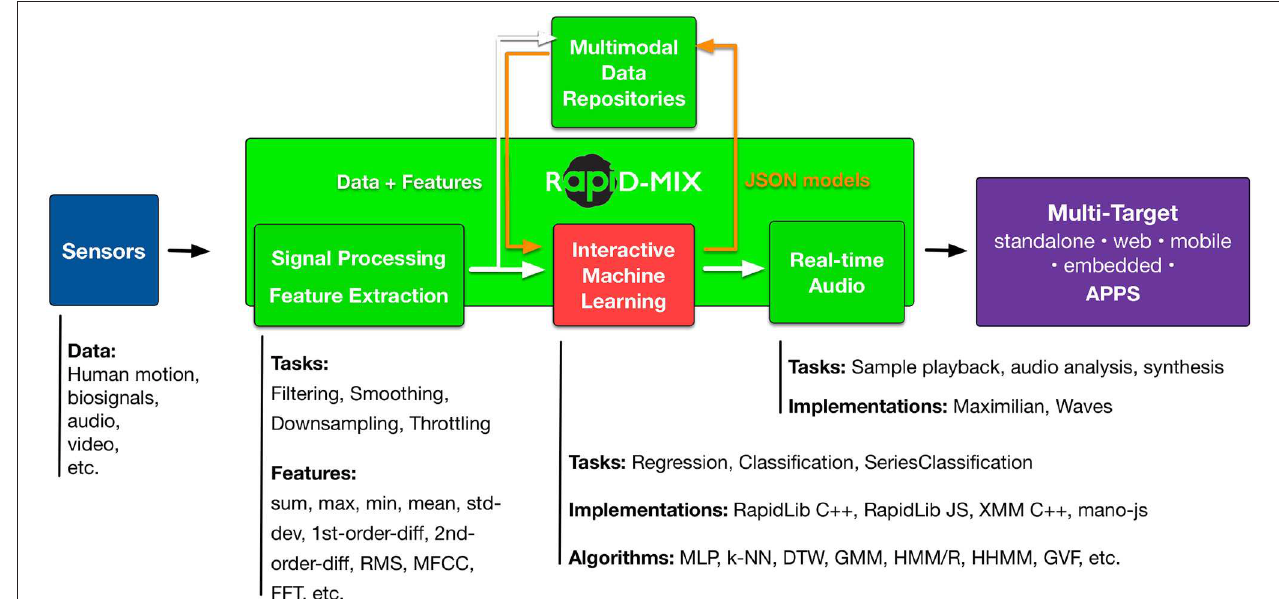
FIGURE 1 | General structure of the RAPID-MIX